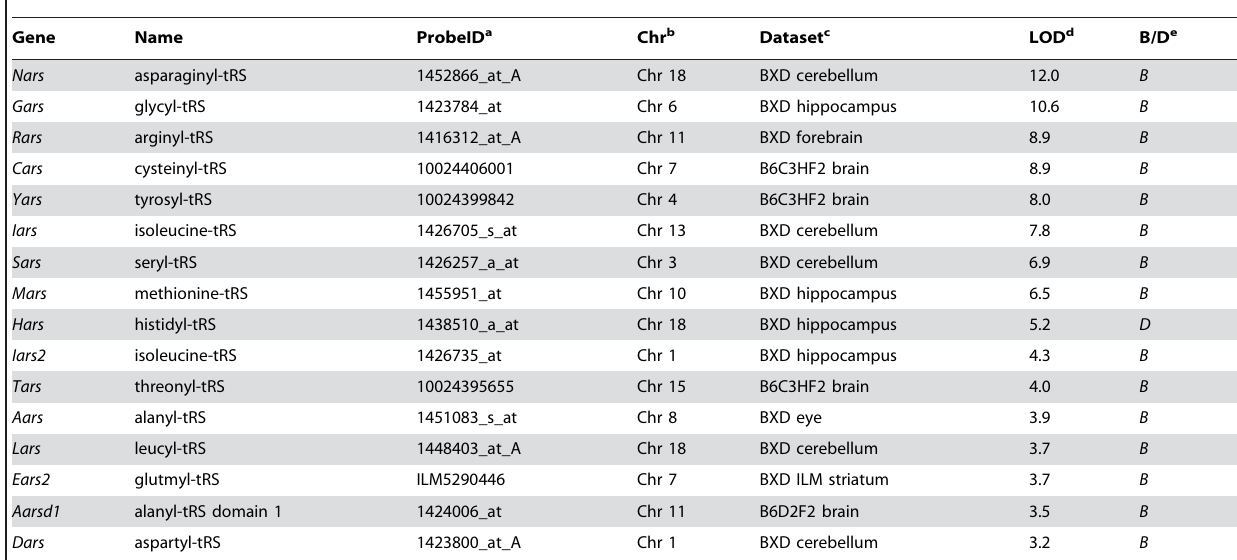
Table 5. Transcripts of aminoacyl tRNA synthetases that have trans -QTLs in Qrr1 (LOD $ 3) in one or multiple CNS datasets.